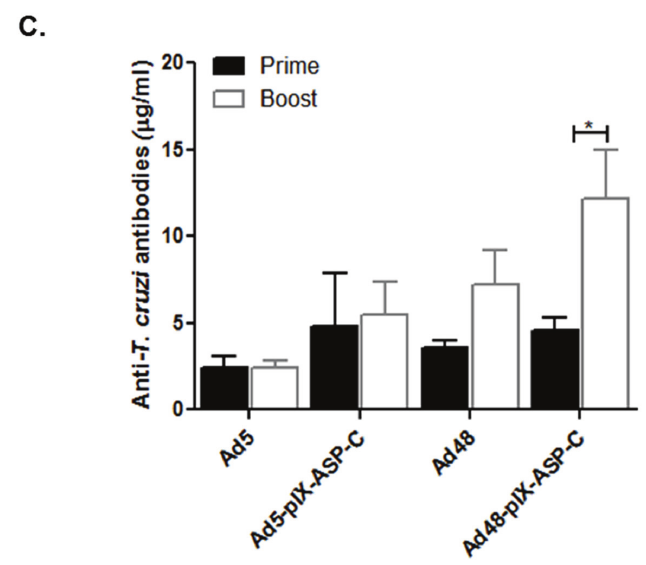
Figure 6. Antigen capsid-incorporation vector elicits an in vivo T. cruzi humoral immune response. ( A ) Study design: C57BL/6 mice ( n = 7) were primed and boosted with 3 × 10 10 VP of Ad5, Ad5-pIX-gp83, Ad5-pIX-ASP-C, Ad48, Ad48-pIX-gp83, or Ad48-pIX-gp83. Two weeks after the last immunization serum was collected for ELISA binding assays. Either 10 µ M of gp83 peptide or the ASP-C peptide was bound to ELISA plates; ( B ) Post-prime and post-boost serum from mice immunized with the T. cruzi gp83 modified vectors; ( C ) Post-prime and post-boost serum from mice immunized with the T. cruzi ASP-C pIX - modified vectors. The amount of anti-gp83 and anti-ASP-C antibodies in the sera was expressed as the mean ˘ SEM. (*) = p ď